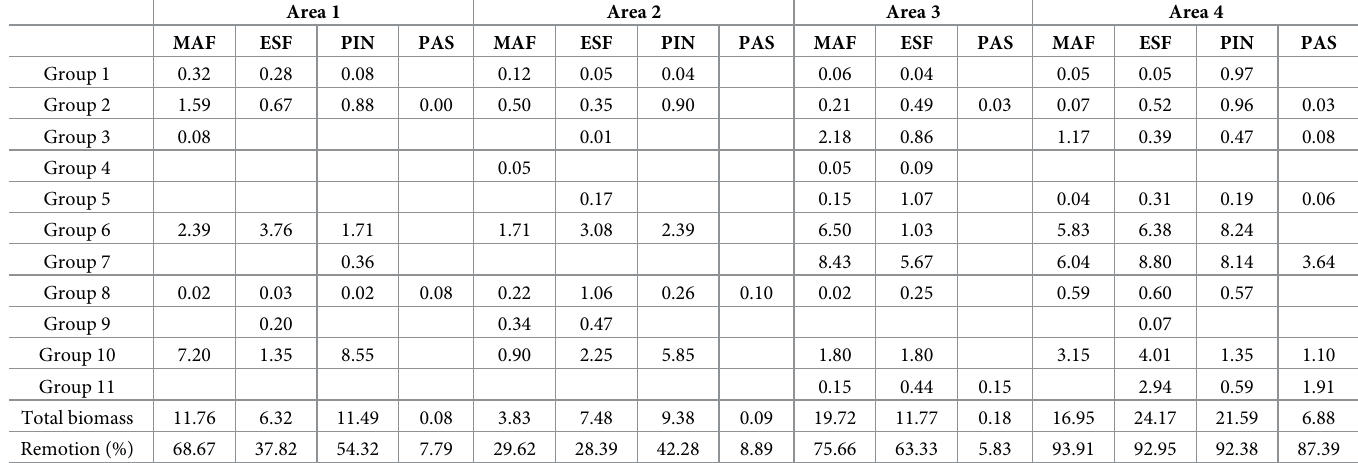
Table 6. Biomass contribution (g) of each functional group of dung beetles in four habitats with differences in land use: Mature forests (MAF), Early succession for- ests (ESF), Pinus monoculture (PIN), Pastures (PAS). Area